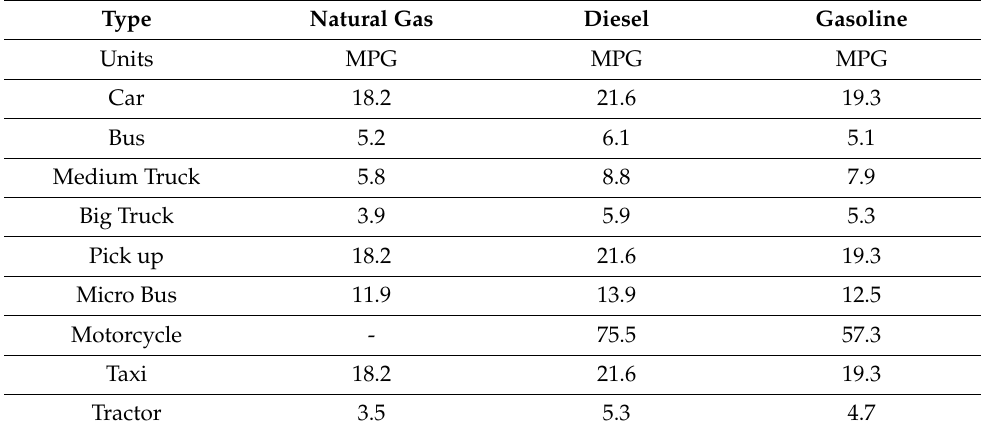
Table 3. Fuel economy by fuel and type of vehicle for the base year [27,32–37].